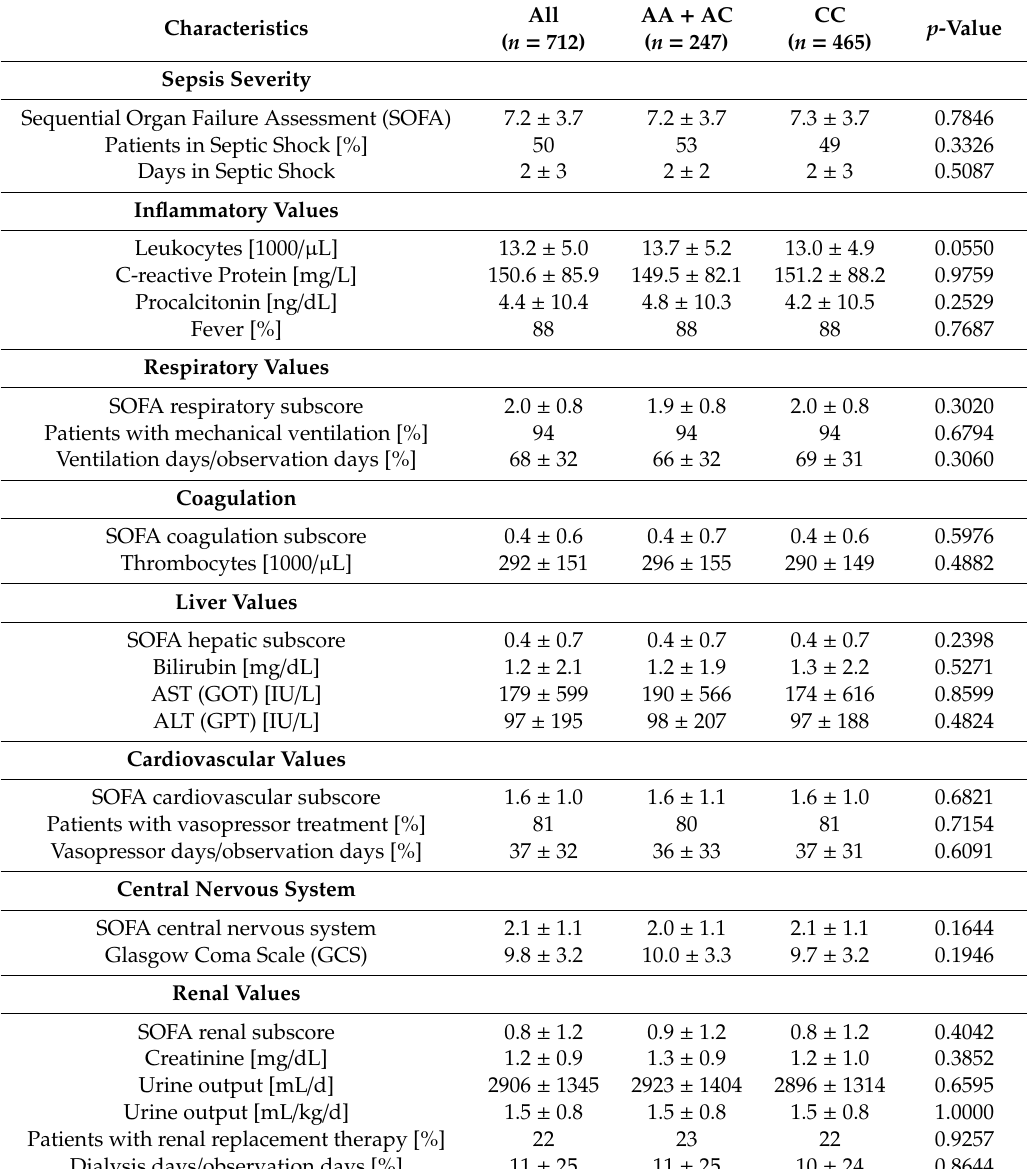
Table 4. Disease severity regarding the TIM-3 rs10515746